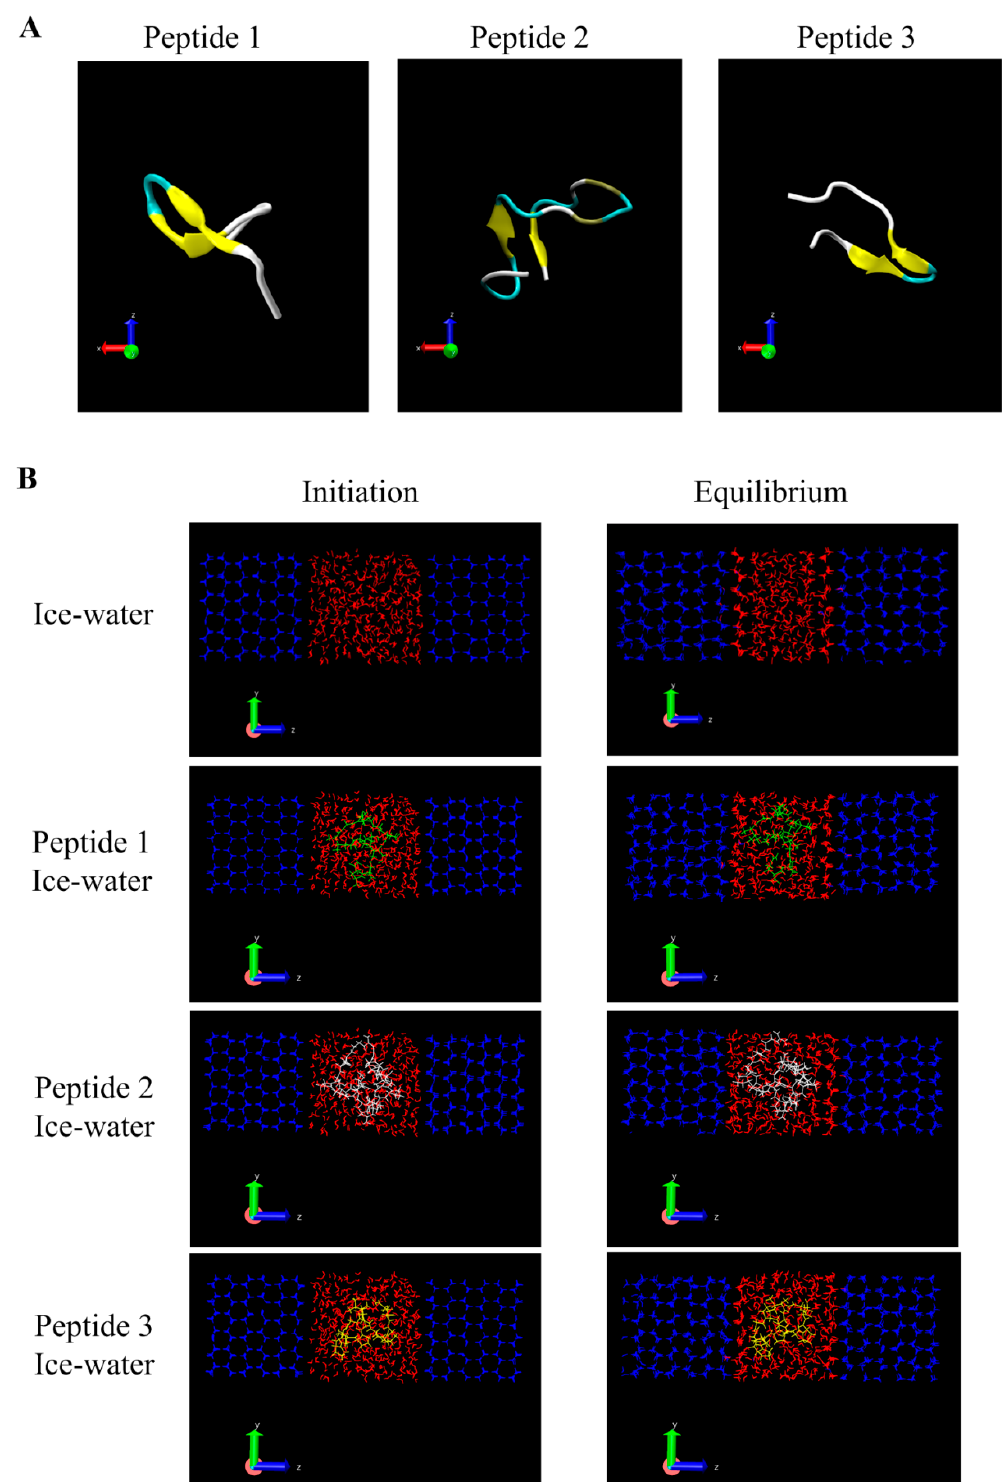
Figure 7. The molecular structure of GCFSC-AFPs (three peptides) shown in a secondary structure model ( A ) and a snapshot of the ice-water system and the three peptides in the ice-water system ( B ). The left panel represents the initial configuration of the system, and the right panel represents the balanced snapshot. Red, blue, green, white, and yellow represent water, ice, peptide 1, peptide 2, and peptide 3, respectively. Data were expressed as the mean ± SD.